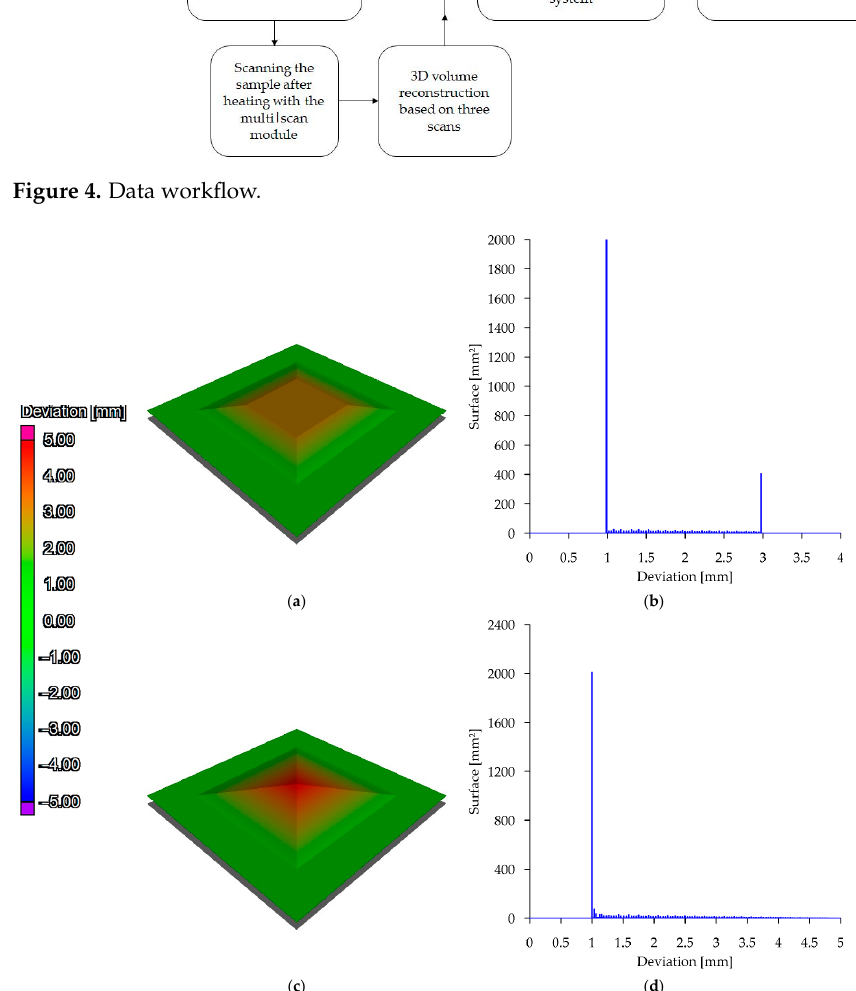
Figure 5. Deviation analysis methodology: ( a ) model with trapezoidal elevation; ( b ) deviation dia- gram; ( c ) model with triangular elevation; ( d ) deviation diagram.